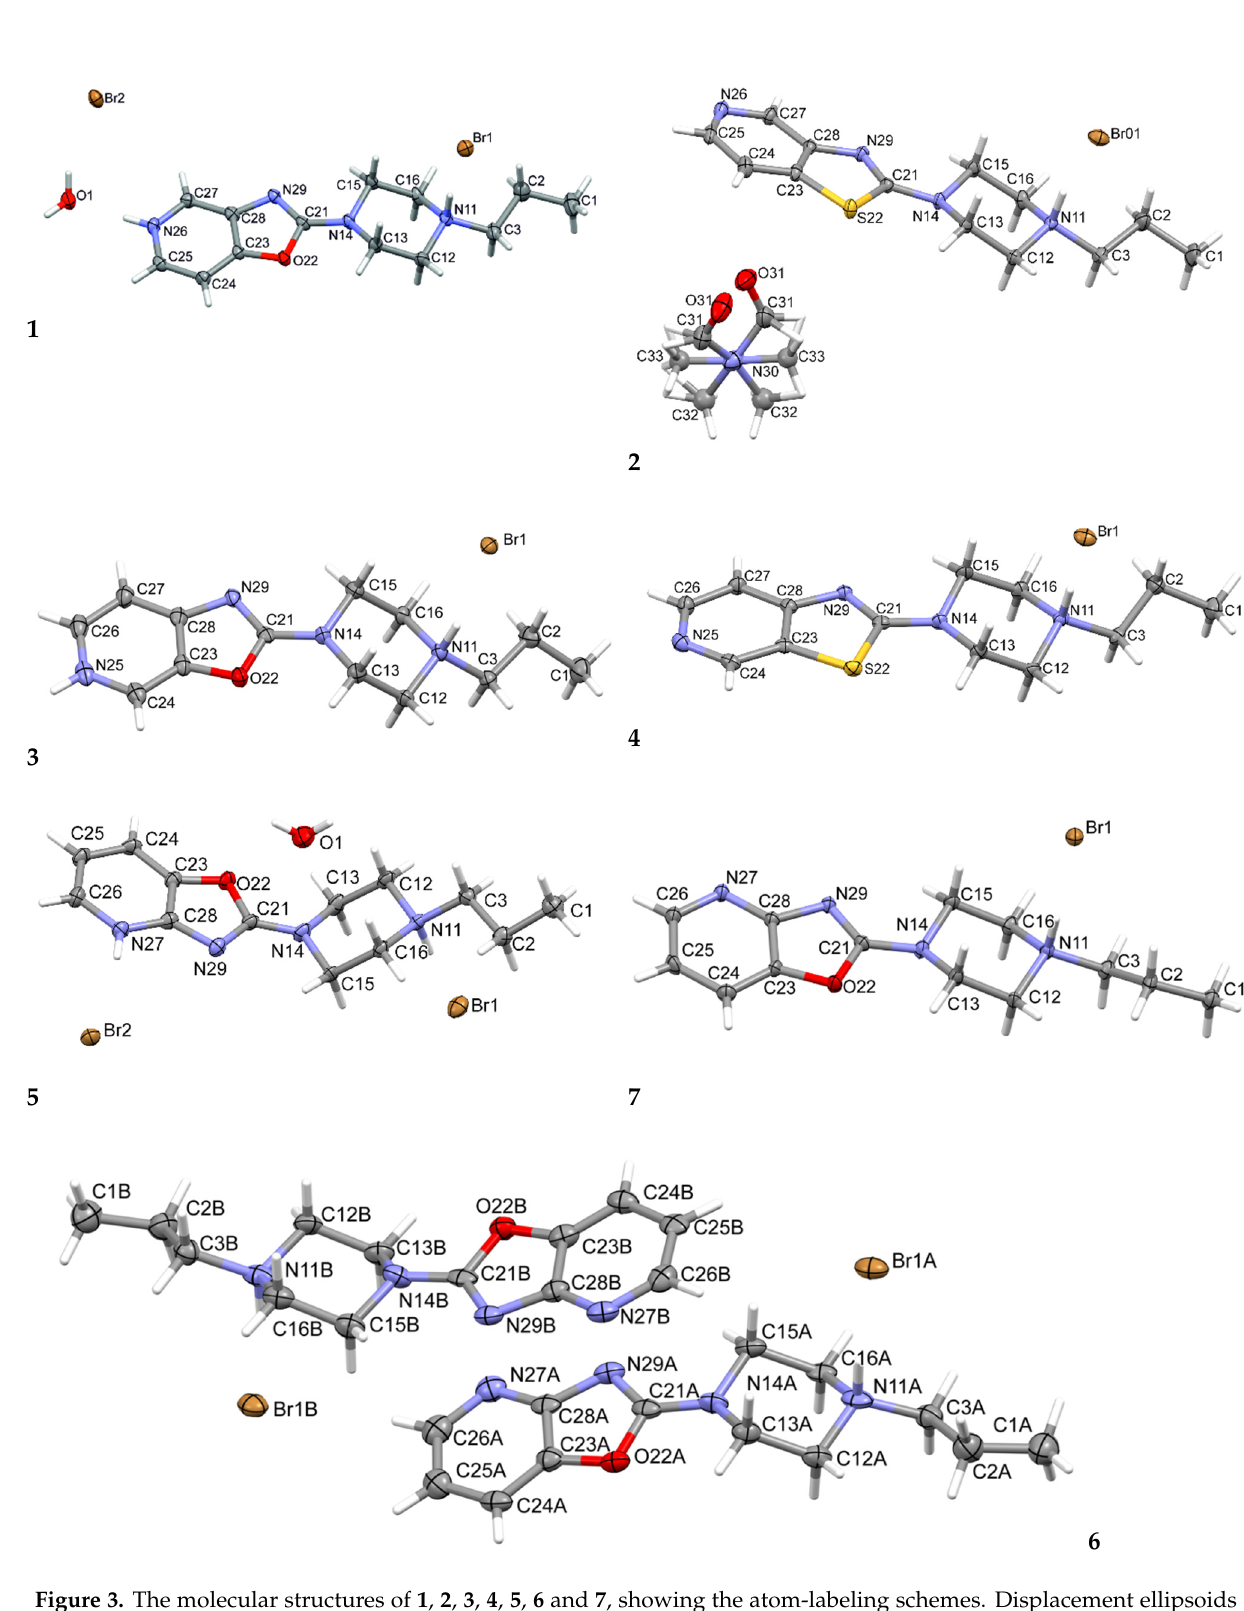
Figure 3. The molecular structures of 1 , 2 , 3 , 4 , 5 , 6 and 7 , showing the atom-labeling schemes. Displacement ellipsoids are drawn at the 50% probability level and H atoms are shown as small spheres of arbitrary radii. Drawing prepared with Mercury software [30].